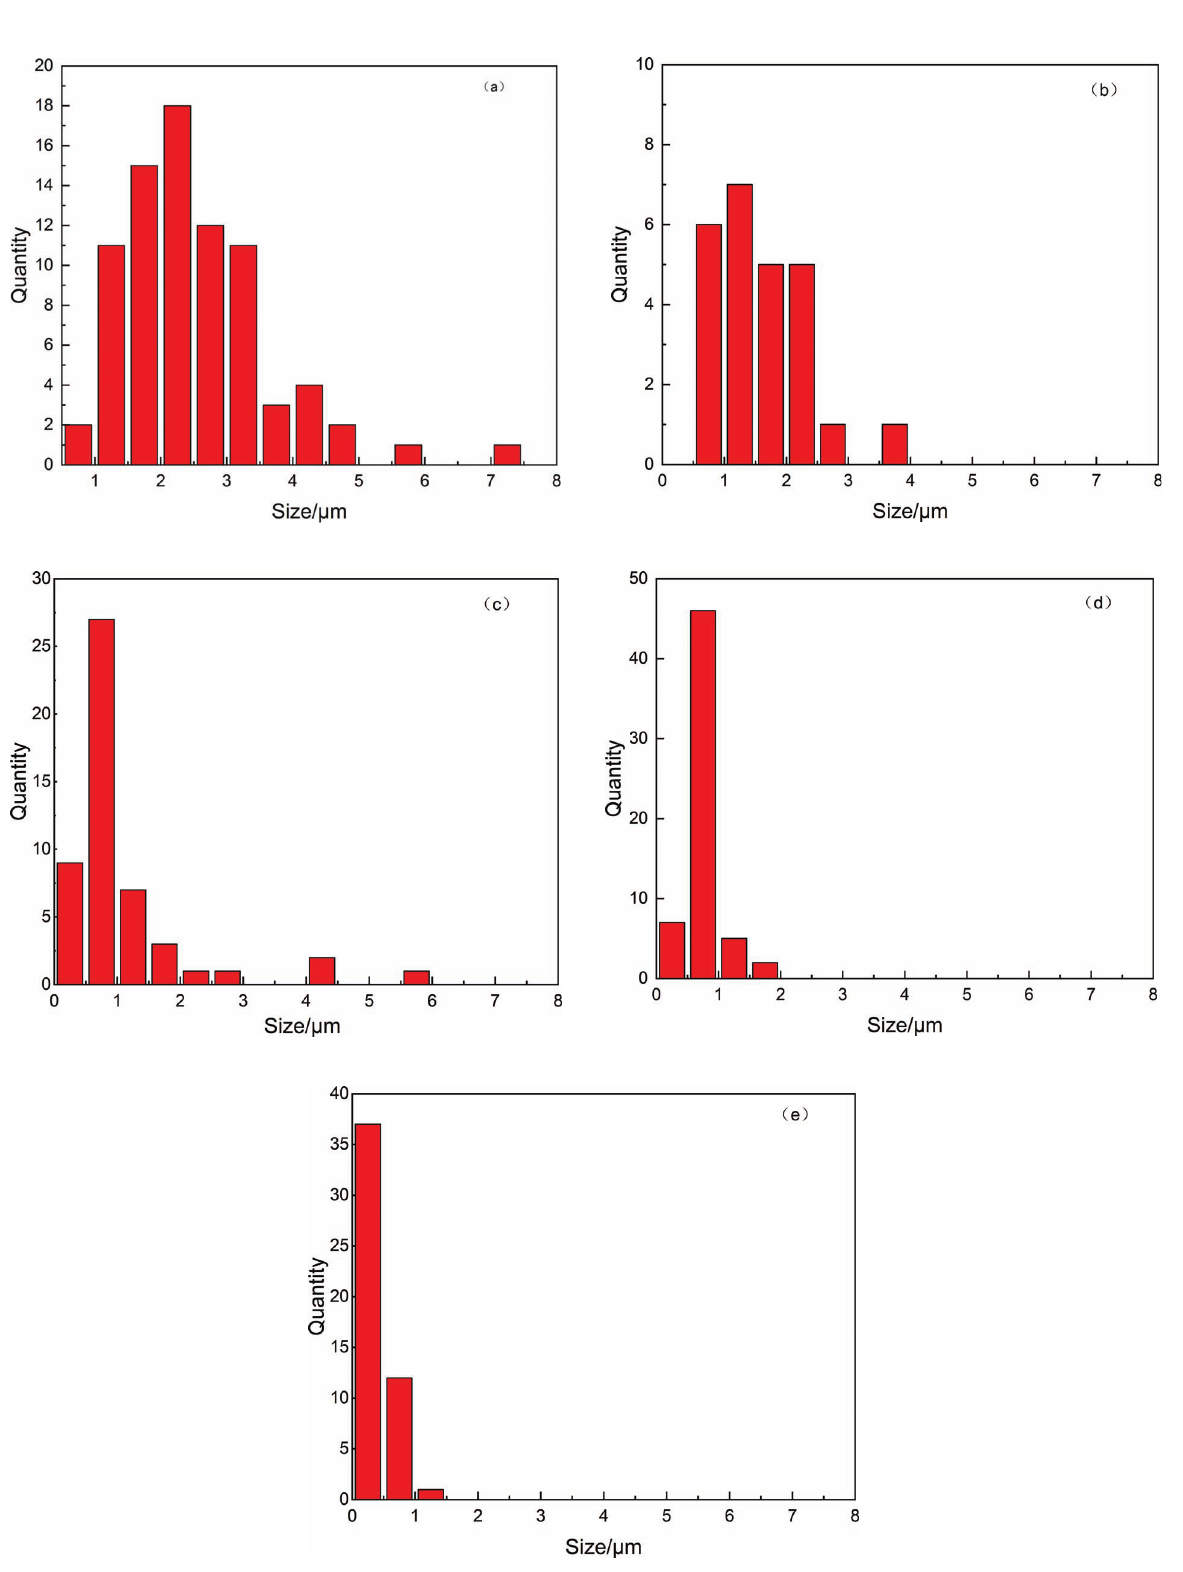
Figure 8: Particle size distribution of the impact fracture surface of the PLA/PBAT blends with different ETBP content: (a) neat, (b) 0.5 phr, (c) 1.0 phr, (d) 3.0 phr and (e) 5.0